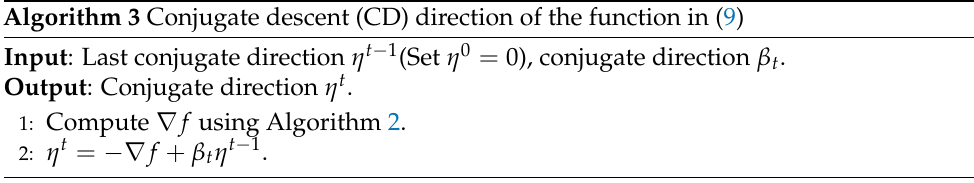
Algorithm 3 Conjugate descent (CD) direction of the function in